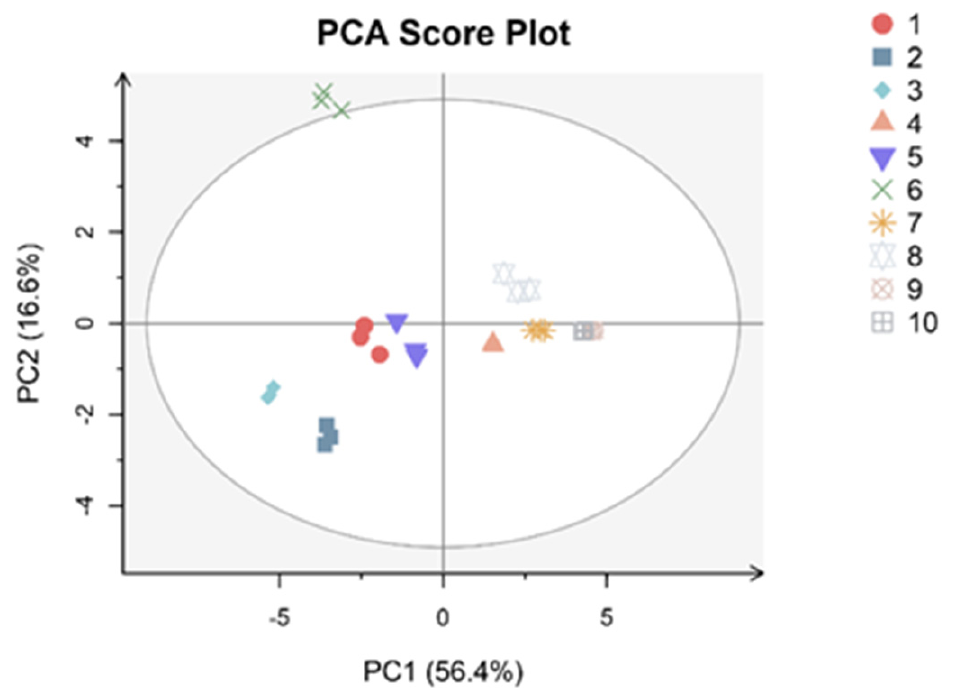
Figure 1. Principal component analysis (PCA) of amino acid data of 10 peach and nectarine varieties in a 2D graph of PC1 and PC2. 1 indicates Jinxia; 2 indicates Yuhua3; 3 indicates Tropic Prince;